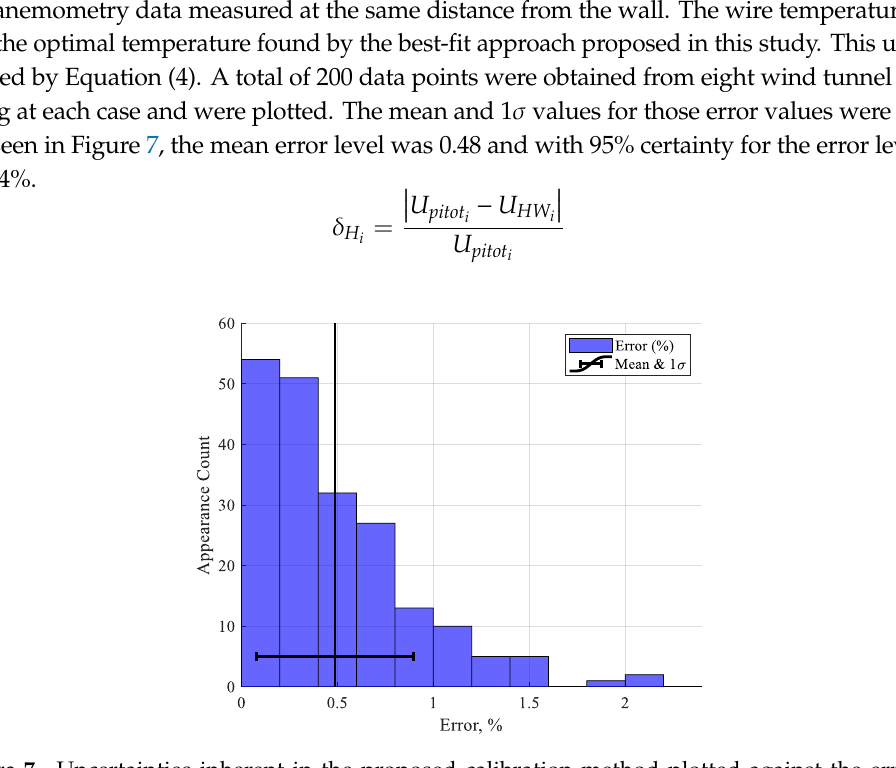
Figure 7. Uncertainties inherent in the proposed calibration method plotted against the error of velocity velocity calibration.